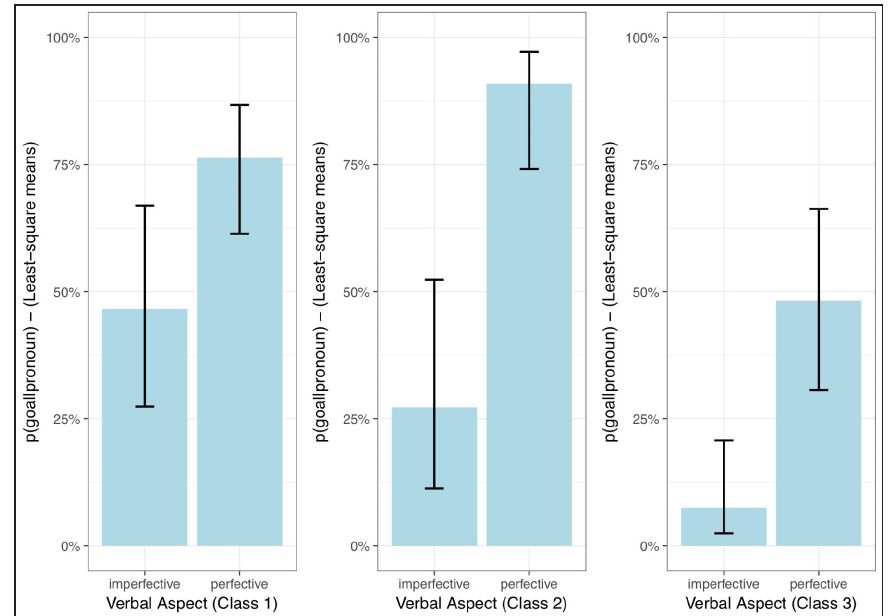
Figure 2: Effect of verbal aspect and verb class on pronoun